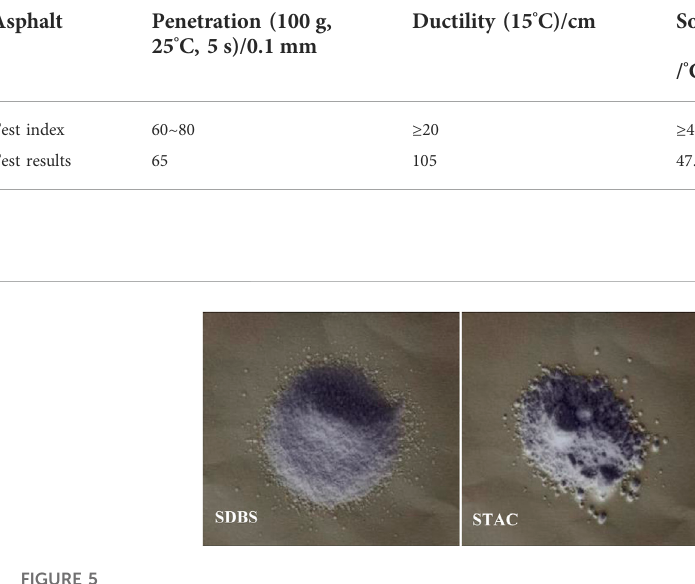
FIGURE 5 The SDBS and STAC emulsi fi ers and the Herbert Rink colloid mill.